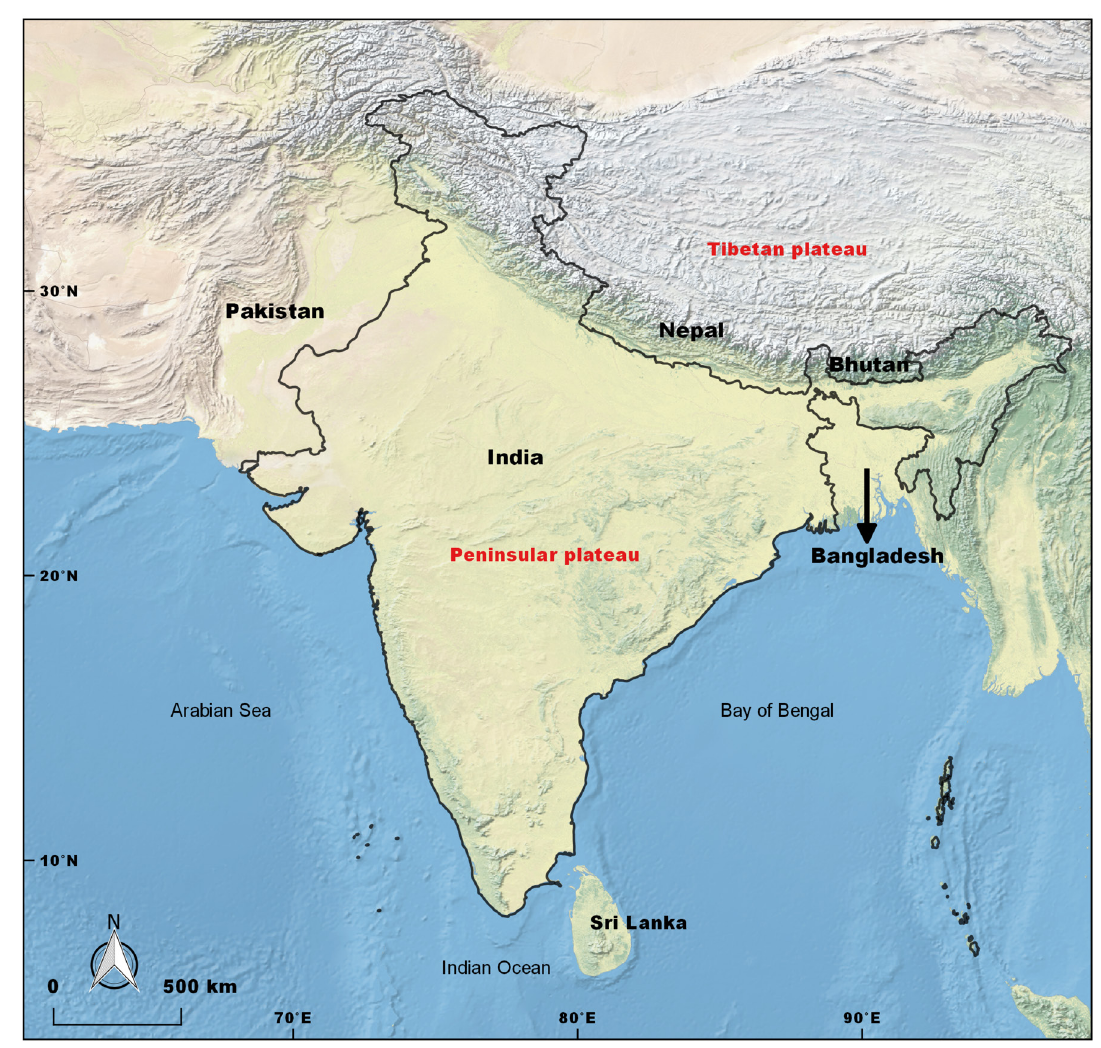
Fig. 1. Overview of the Indian subcontinent and its main geographic